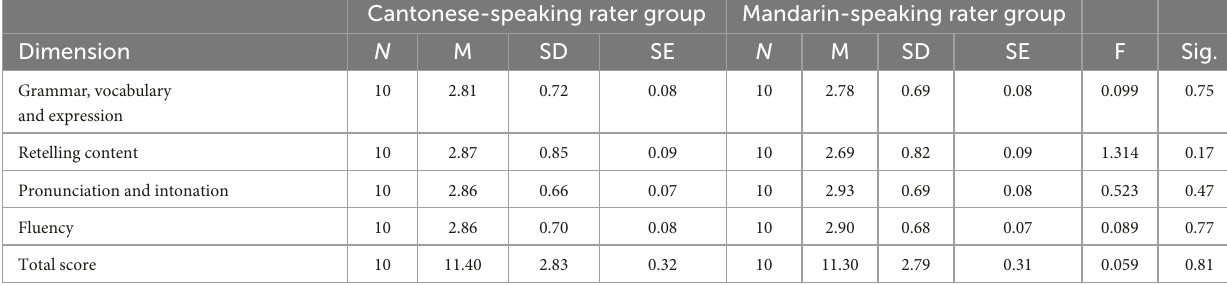
TABLE 2 Two-factor ANOVA results for within group analysis.